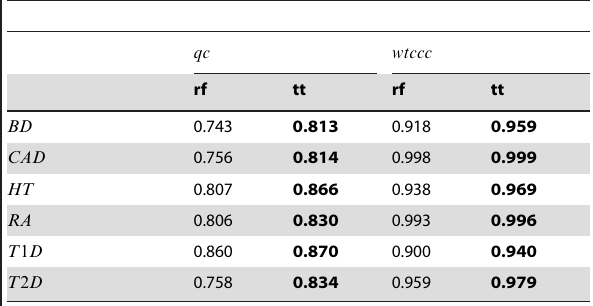
Table 4. Predictive power: auc comparisons on the six other WTCCC